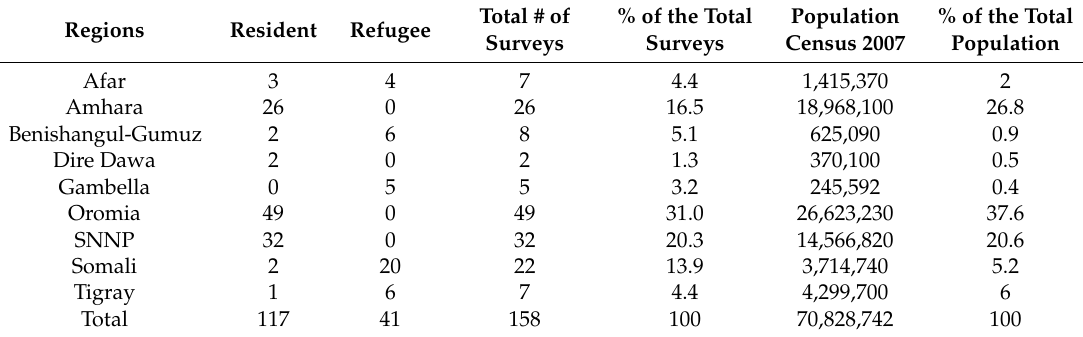
Figure 1. Prevalence of GAM by district, Ethiopia, 2008–2013. Table 2. Survey distribution by region and population status, Ethiopia emergency pockets,